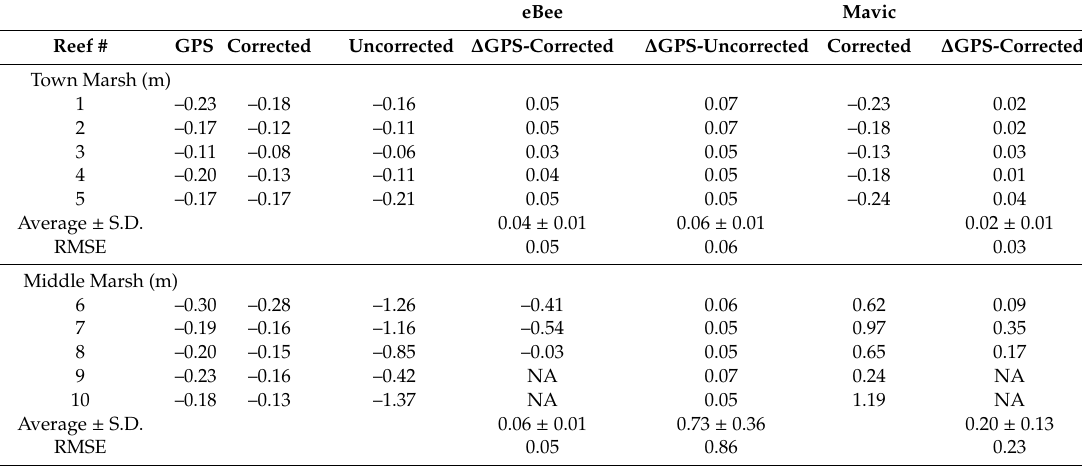
Table 2. GPS and UAS-derived intertidal average oyster reef elevation measurements in meters (NAVD88) from five reefs located in Town Marsh and Middle Marsh from a corrected eBee and uncorrected with GCPs and a Mavic Pro corrected with GCPs. Only three intertidal reef area measurements are included in the Mavic flights at Middle Marsh due to a small flight extent.